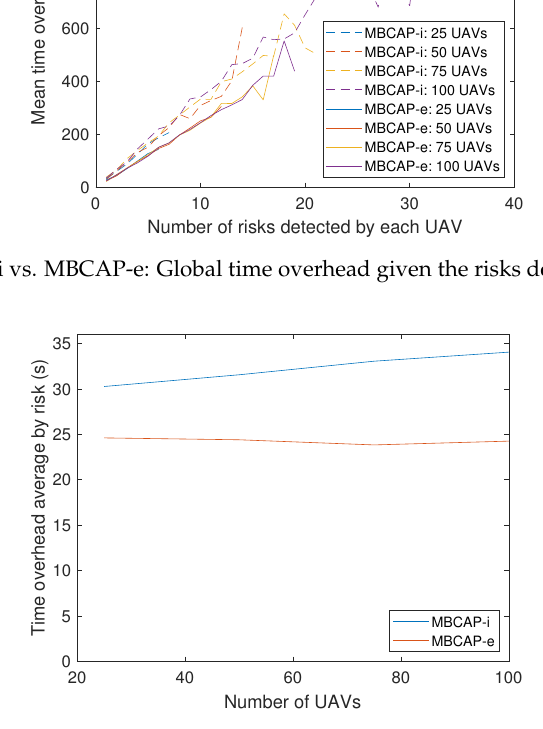
Figure 19. MBCAP-i vs. MBCAP-e: Time overhead by risk detected vs. number of